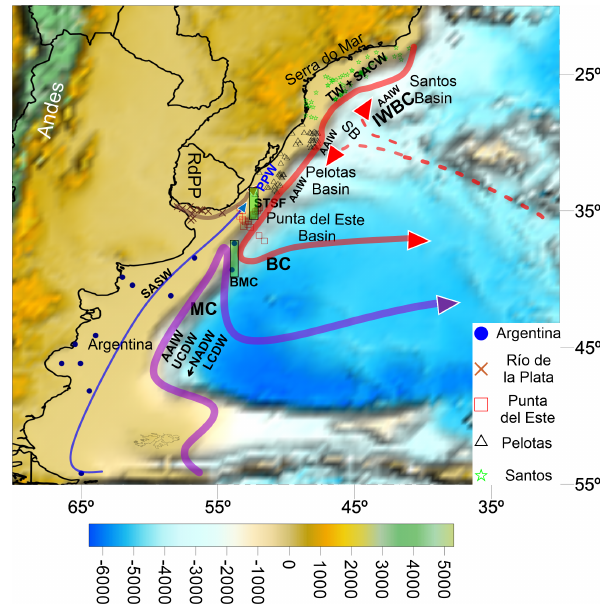
Figure 1. Location of the study area, displaying the main flows, oceanographic boundaries, and sampling stations. Thick violet line: Malvinas Current (MC); thin blue line: Subantarctic Shelf Water (SASW); thin brown line: Río de la Plata Plume (RdlPP); thick red line: Brazil Current (BC); shaded rectangles: Subtropical Shelf Front (STSF) and Brazil–Malvinas Confluence (BMC); dashed red line: Santos Bifurcation (SB) and Intermediate Western Boundary Current (IWBC). Other abbreviations: Antarctic Intermediate Wa- ter (AAIW), Upper Circumpolar Deep Water (UCDW), North At- lantic Deep Water (NADW), and Lower Circumpolar Deep Water (LCDW). Bottom scale: topography in